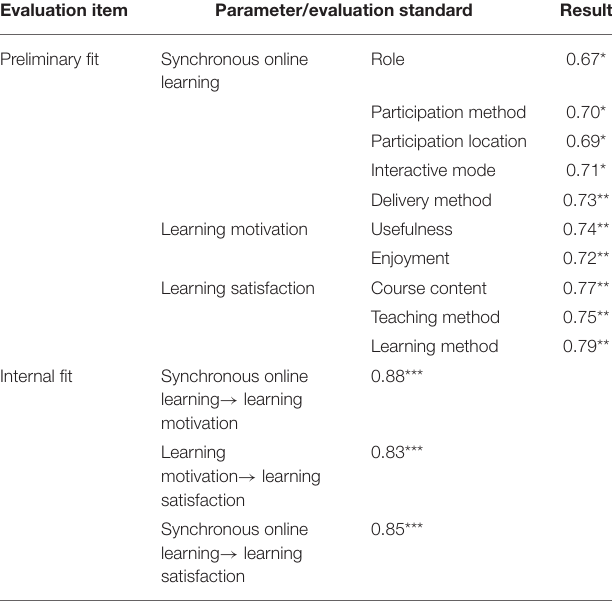
TABLE 3 | Overall linear structural model analysis result. Evaluation